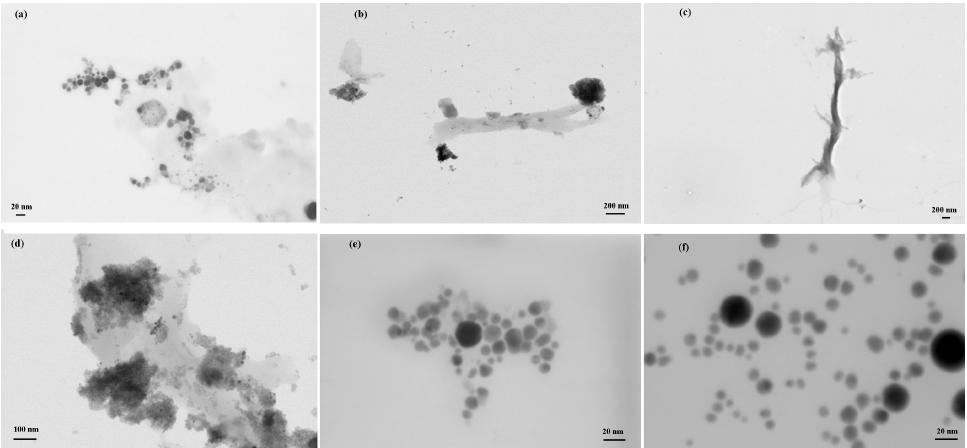
Figure 5. Representative STEM images of the samples: 3:1 Ag@LCCs ( a , b ), 1:3 Ag@LCCs ( c , d ), Ag NPs within the 3:1 Ag@LCCs ( e ), and water-ablated Ag NPs ( f